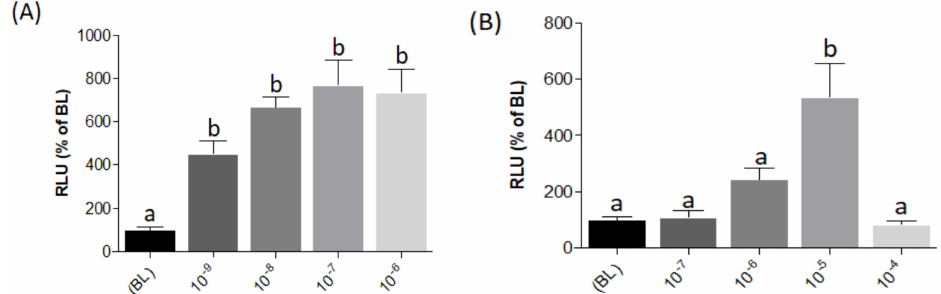
Figure 4. Evaluation of pGL3- NFAT -luc construct responsiveness to 10-fold serial dilutions to PMA ( A ) and ionomycin ( B ) in transiently transfected HEK293 cells. RLU%: Relative Luminescence Unit percentage. Evaluation of L-AA responses was based on the RLU mean ± SEM of four independent determinations normalized to the mean response of the same transfections ( n = 4) stimulated with assay medium (Dulbecco’s Modified Eagle Medium (DMEM) + 1% fetal bovine serum (FBS)). BL (Basal Levels) = 100% RLU. Di ff erent lowercase letters (a,b) on top of bars indicate significant di ff erences ( p < 0.05) between concentrations, assessed by one-way ANOVA followed by Tukey’s Multiple Comparison Test (GraphPad Prism version 5.00 Software, La Jolla, CA, USA).